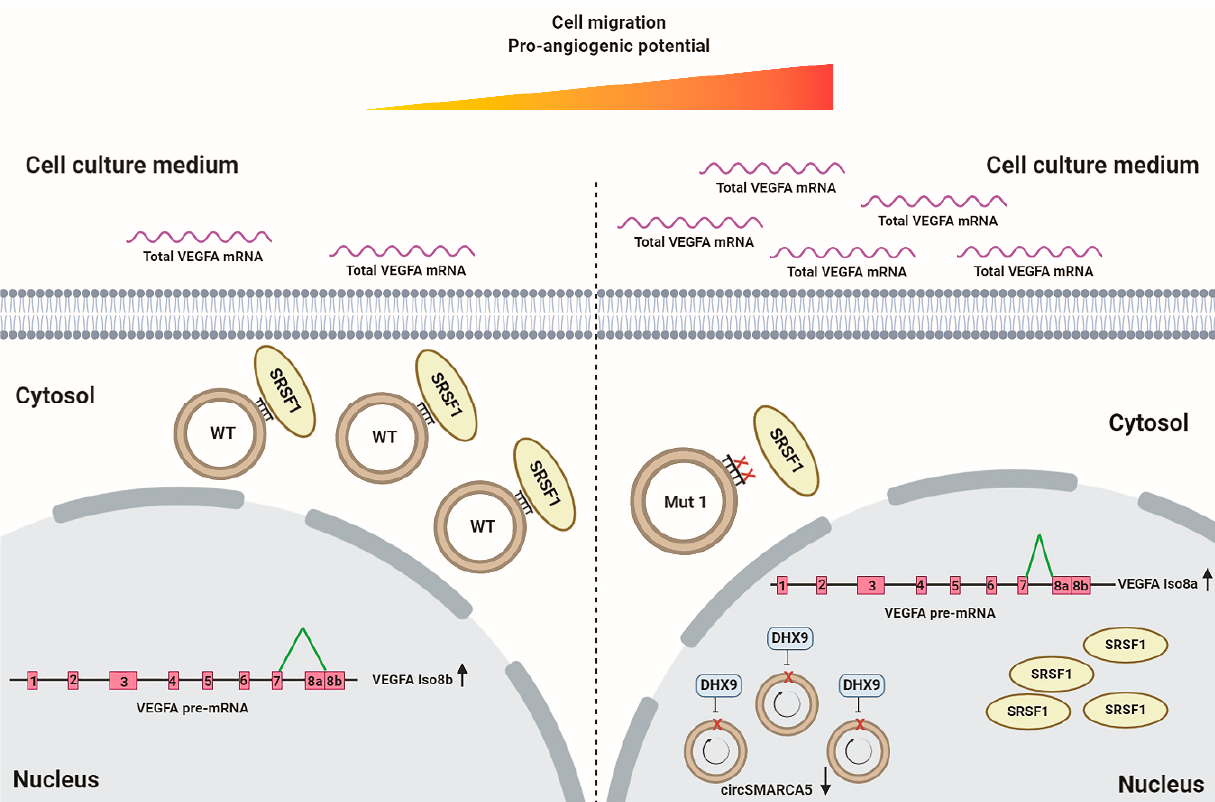
Figure 7. Schematic representation of the proposed mechanism of action of WT and Mut1 circSMARCA5 within GBM cells. Left panel: SRSF1 pro-oncogenic activity is negatively affected in GBM cells overexpressing WT circSMARCA5. The latter acts as a decoy for SRSF1, leading to (i) an increased relative expression of Iso8b vs. Iso8a VEGFA mRNA isoform; (ii) a decreased GBM cell migration and pro-angiogenic potential; (iii) a decreased secretion of total VEGFA mRNA in GBM cell culture medium. Right panel: Mut1 circSMARCA5 is less able to bind SRSF1 than WT circSMARCA5. The decreased decoy activity of Mut1 circSMARCA5 against SRSF1 causes the increase of (i) relative expression of Iso8a vs. Iso8b VEGFA mRNA isoform; (ii) GBM cell migration and pro-angiogenic potential; (iii) the secretion of total VEGFA mRNA in GBM cell culture medium. The biological effects shown in GBM cells overexpressing Mut1 circSMARCA5 resemble the dysregulation of the molecular axis involving circSMARCA5 (downregulated) and its negative regulator DHX9 (upregulated), observed within GBM biopsies. Red boxes indicate exons, black lines indicate introns, and green lines indicate possible splicing patterns leading to the recognition of a canonical (Iso8a) or an alternative (Iso8b) 3 ′ splice site within VEGFA pre-mRNA.